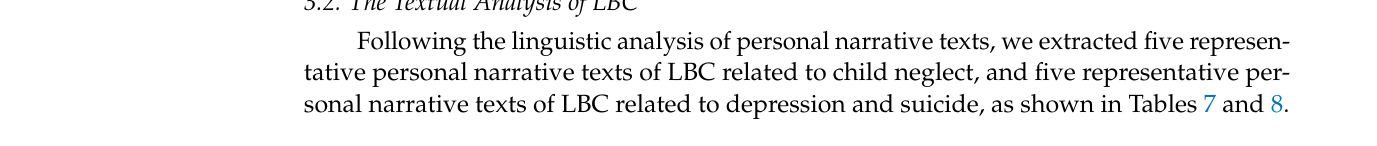
Table 7. Five representative personal narrative texts of LBC related to child neglect.